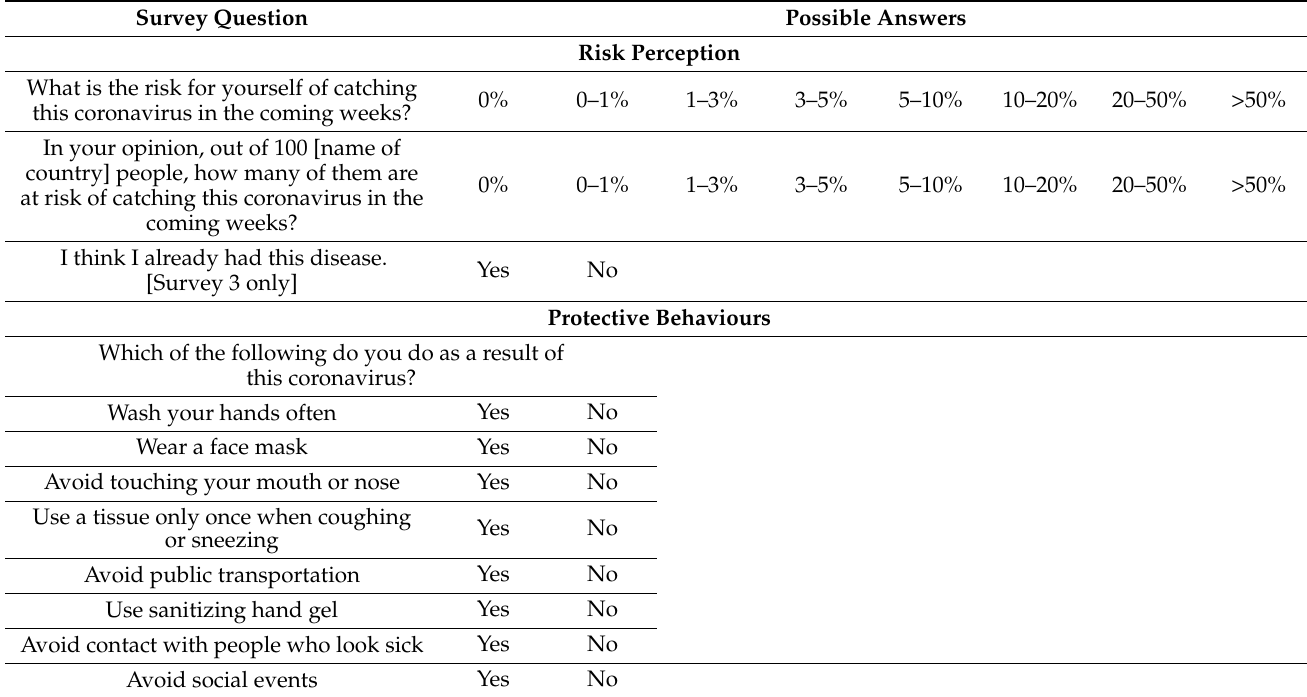
Table 1. Measures: survey questions and